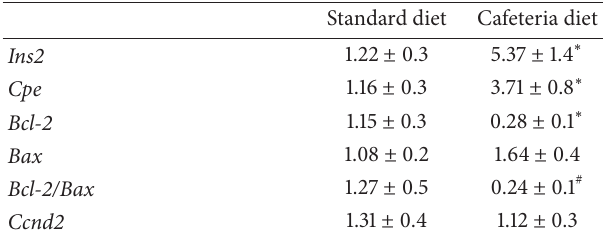
Table 2: Effects of cafeteria diet on gene expression in the pancreas. ∗ 𝑃 ≤ 0.05 and # 𝑃 ≤ 0.1 versus standard diet.